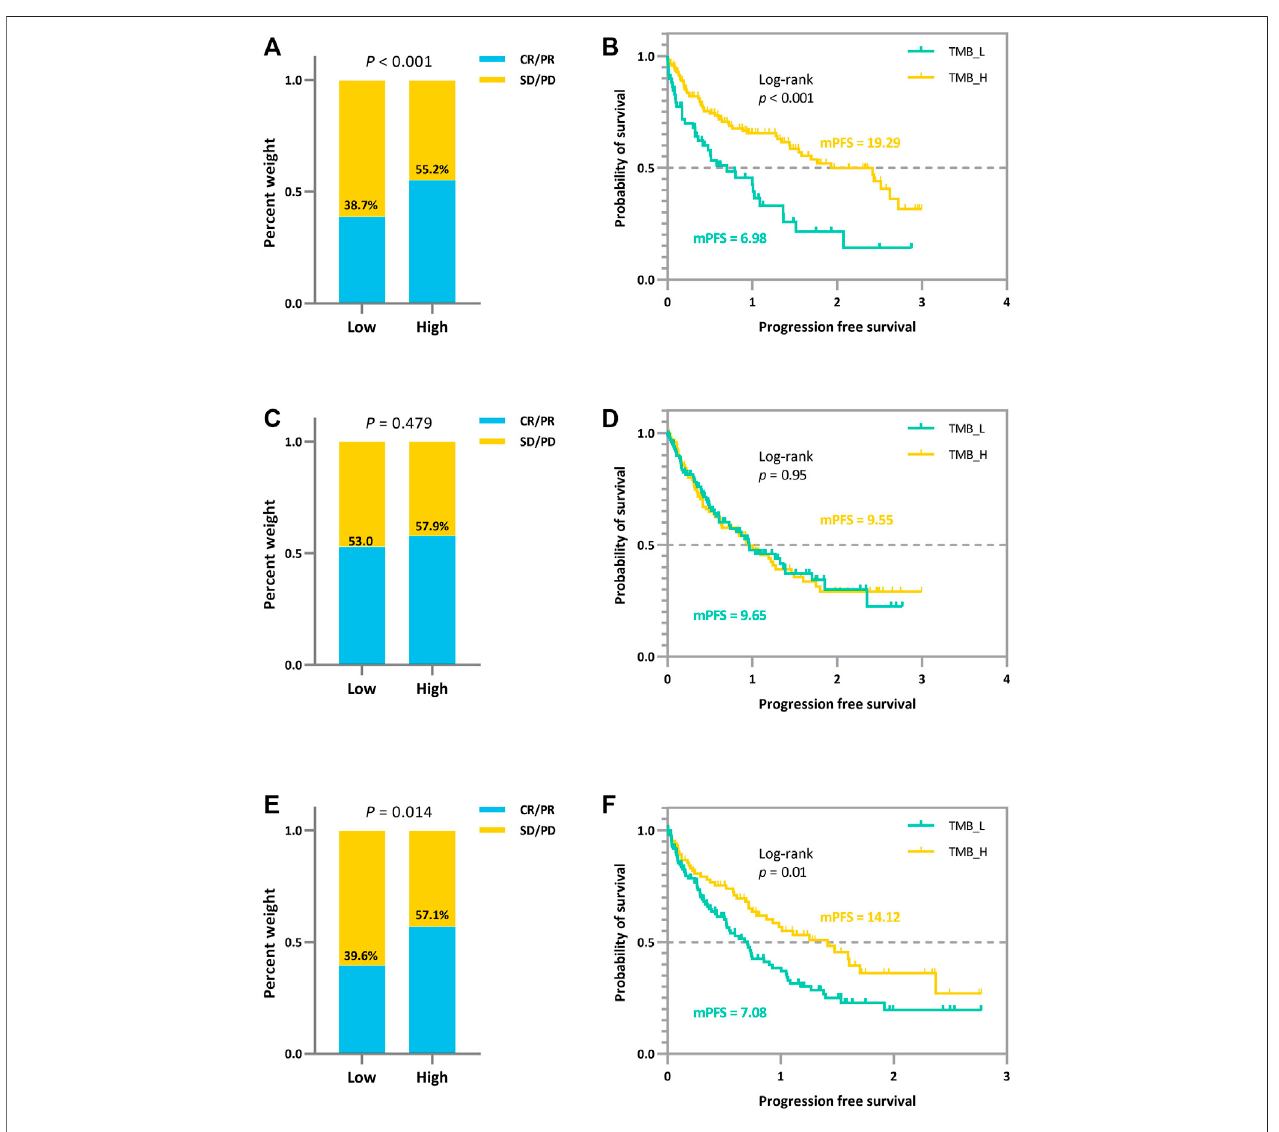
FIGURE 2 | Ef fi cacy comparison of patients grouped based on different TMB thresholds. (A) (B) Comparison of ORR and survival curves based on the threshold derived from the joint statistical inference with TMB actual values. (C) (D) Comparison of ORR and survival curves based on median TMB observations. (E) (F) Comparison of ORR and survival curves based on the threshold derived from the joint-correction statistical inference with TMB observed values.